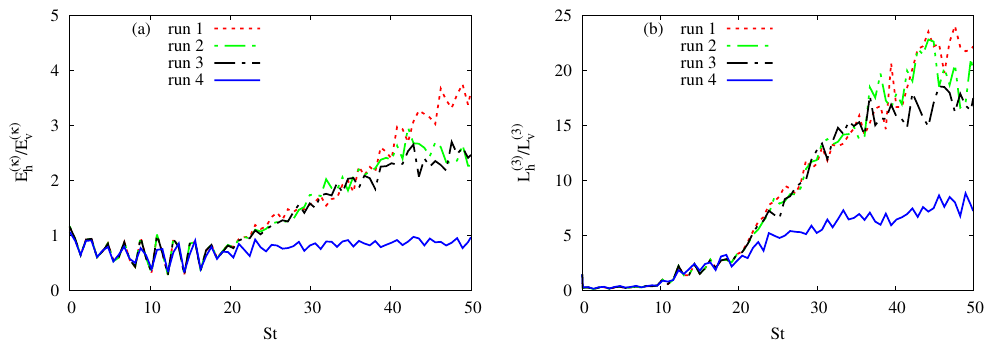
Figure 6. Time evolution of the ratios between horizontal and vertical ( a ) kinetic energies, and ( b ) integral length scales in the vertical ( x 3 ) direction for the runs 1 (PHT case) and 2–4 (PMHDT cases).